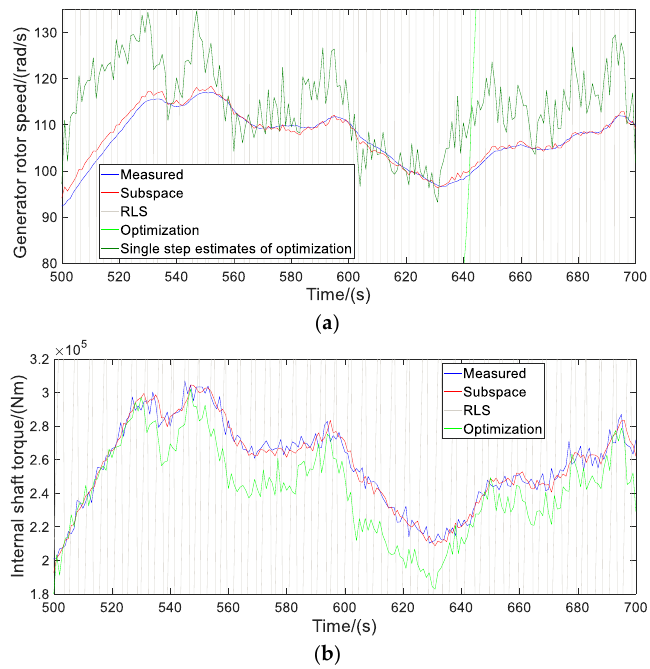
Figure 9. ( a ) Comparison of generator rotor speed under scenario Type 2; ( b ) Comparison of internal shaft torque under scenario Type 2.